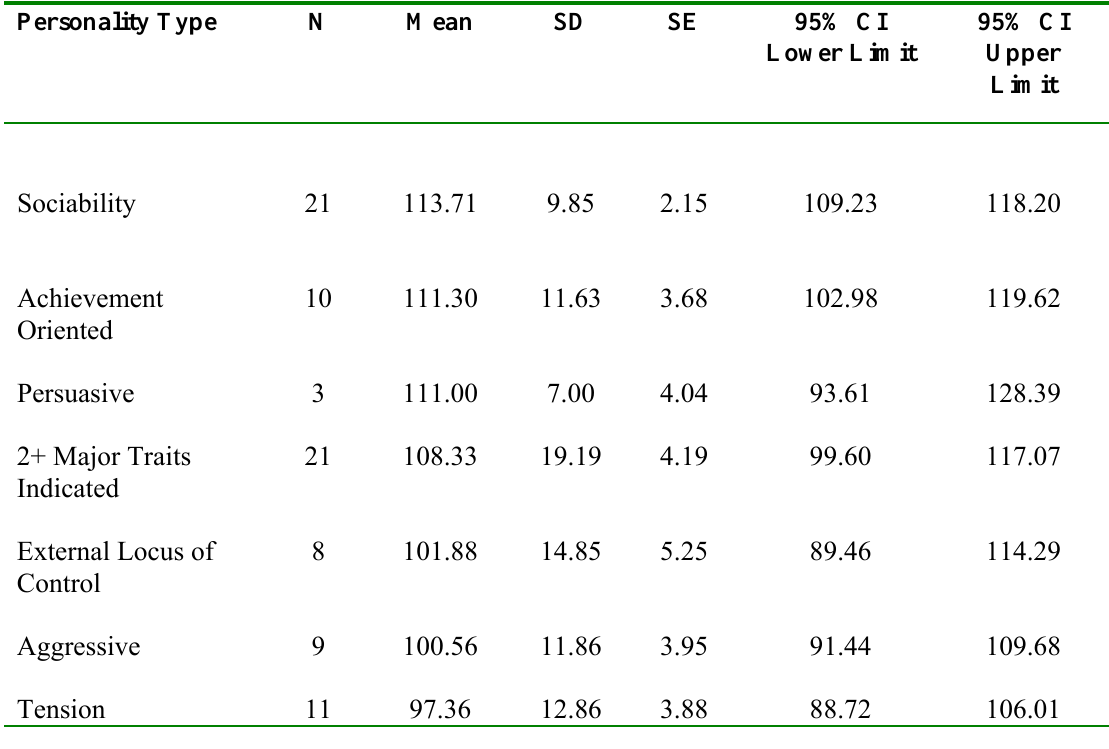
Table 3. Descriptive Statistics of Emotional Intelligence (EI) Scores across Personality Types Personality